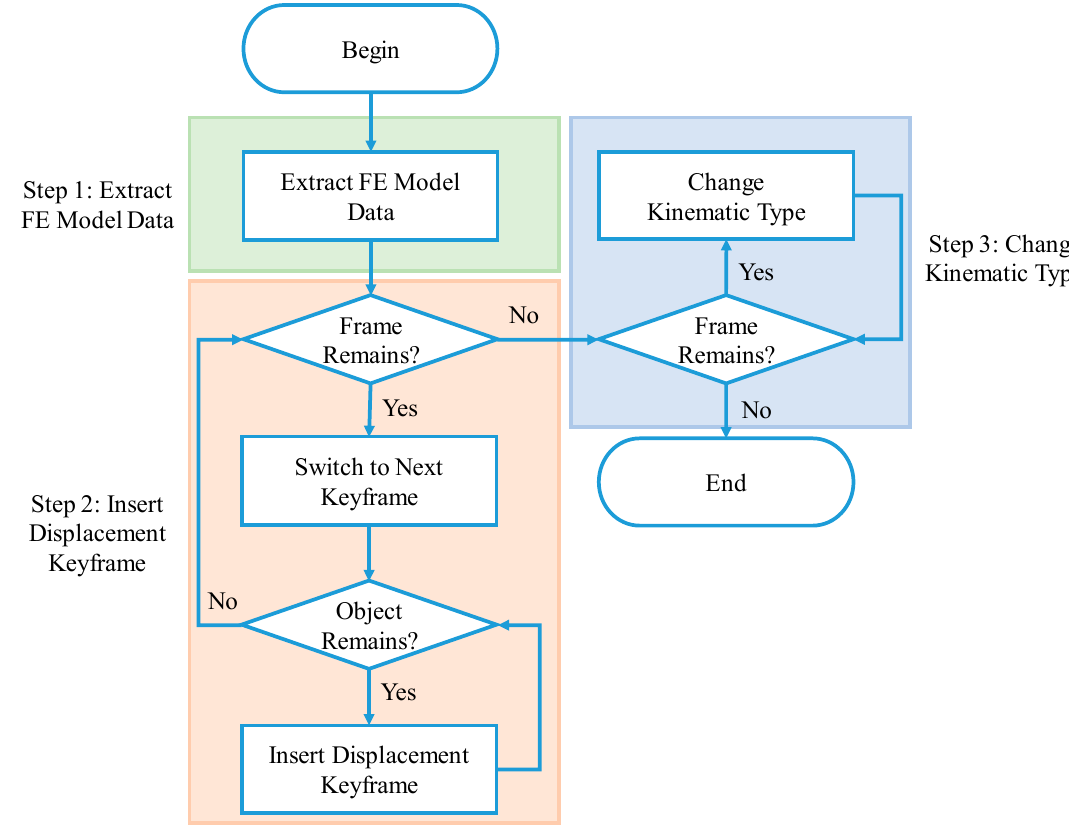
Figure 4. Flowchart of the displacement mapping method.